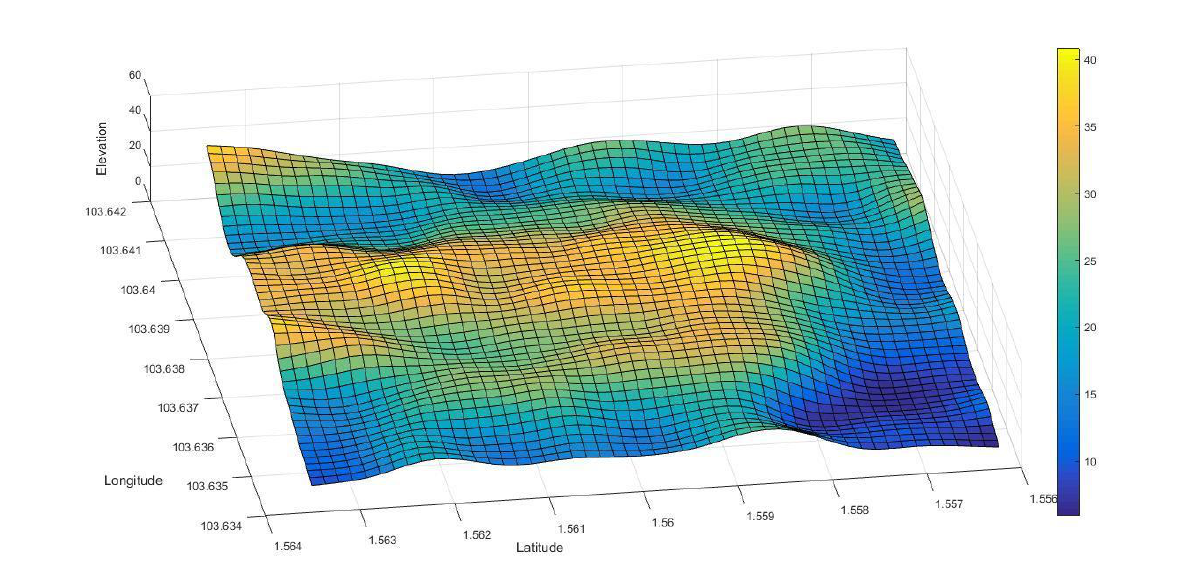
Figure 3. 3D terrain modelling from elevation data using smoothing piecewise cubic spline